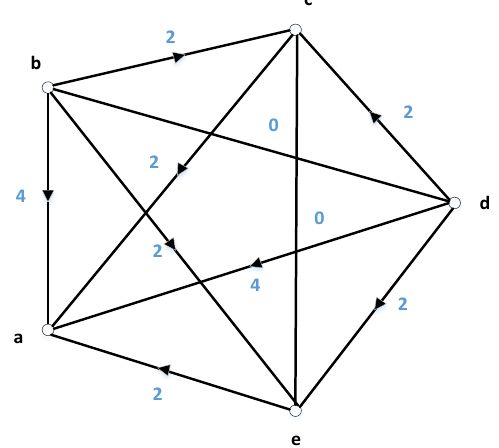
Figure 3. Consistent approximation preference stream.